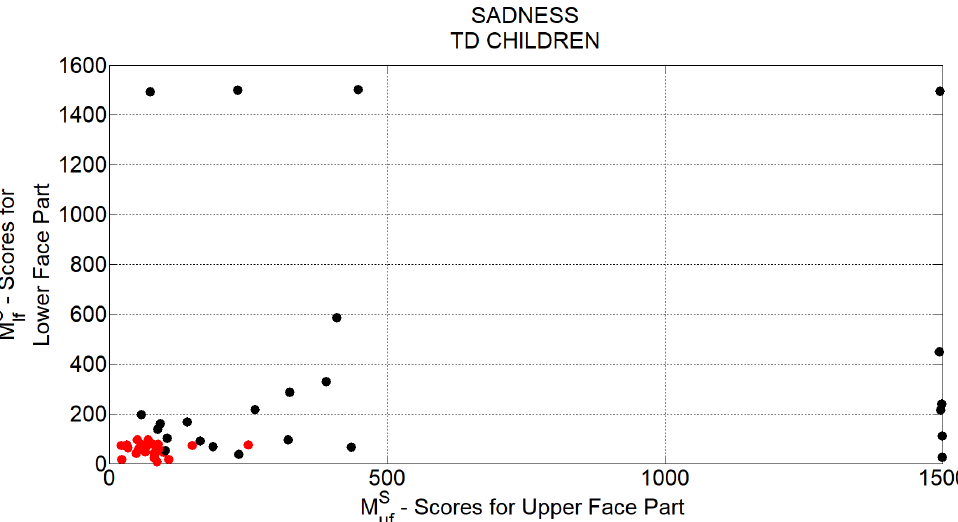
Figure 2. Scores computed for the production of Happy expressions by TD children.